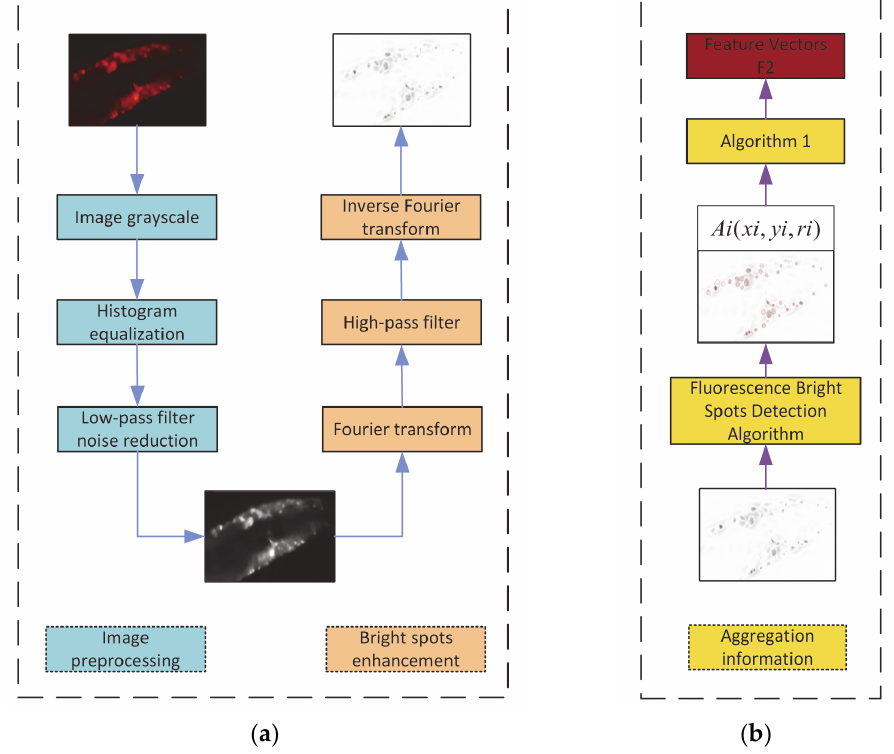
Figure 4. Informational route for fluorescent protein bright spot aggregation degree. ( a ) Image preprocessing. ( b ) Bright spot information extraction and aggregation degree calculation.